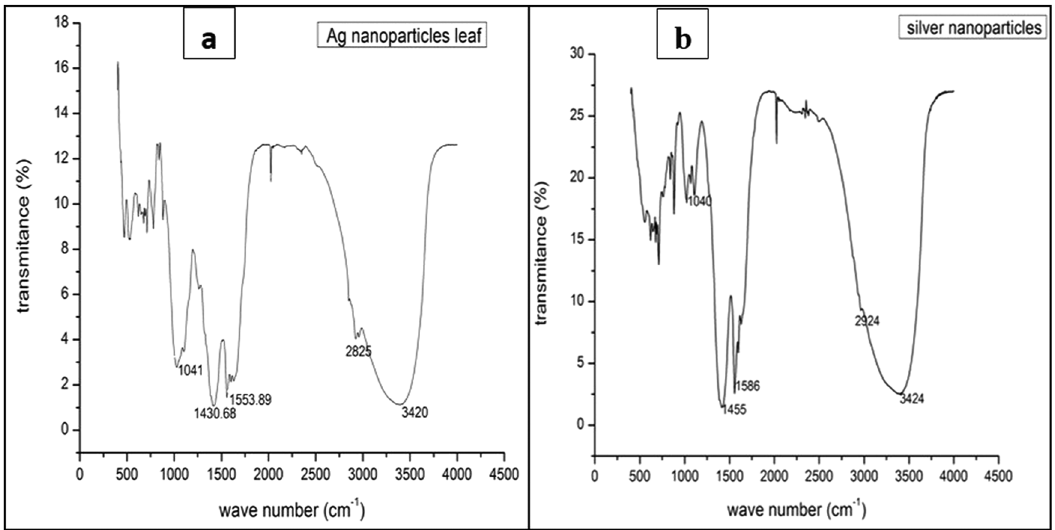
Figure 7: FTIR spectrum of Ag - NPs: ( a ) from leaf and ( b ) from bark of O. ferruginea .